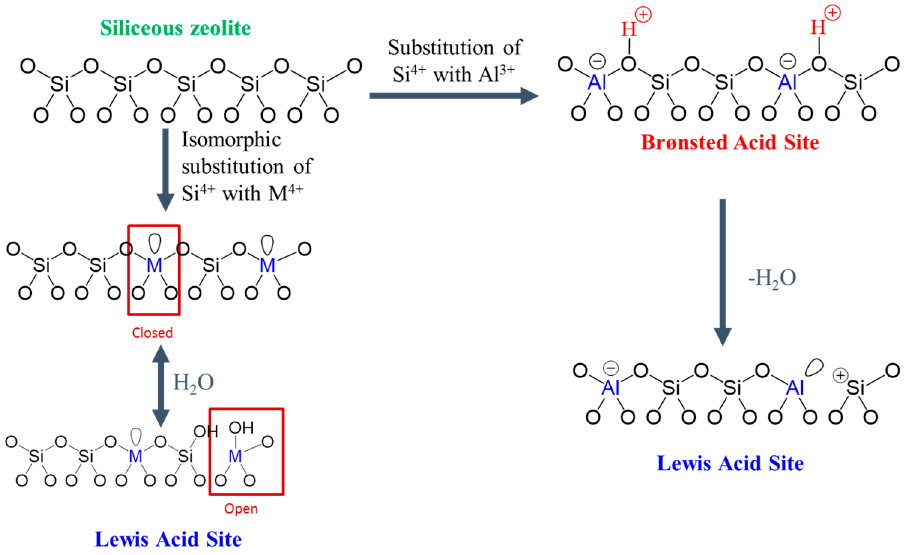
Figure 11. Schematic illustration for structures of Brønsted and Lewis acidity in zeolites.